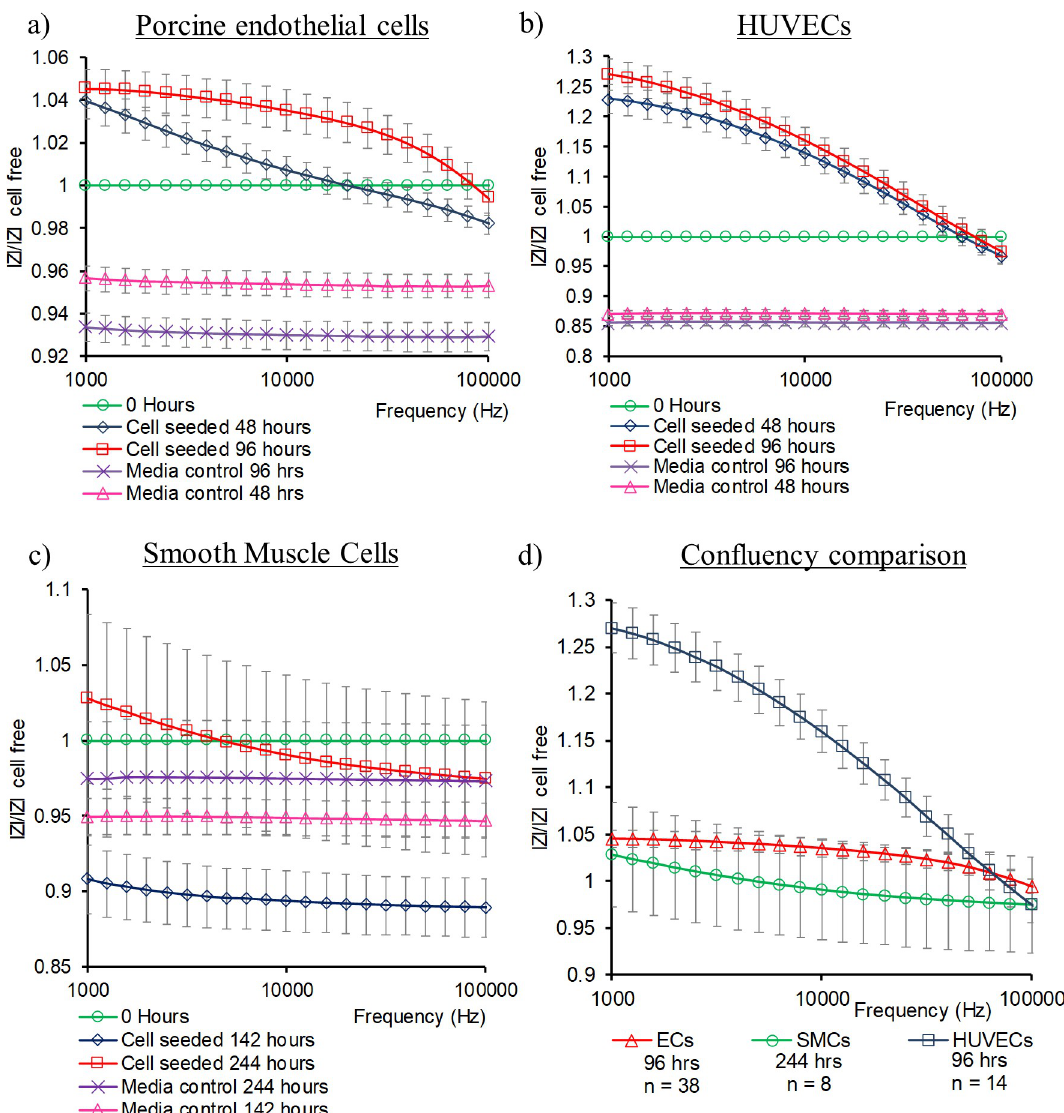
Fig 4. Mean total impedance ratio for confluent monolayers. (A) porcine ECs (n = 38) and media control electrodes (n = 33), (B) HUVECs (n = 14) and media control electrodes (n = 10), (C) SMCs (n = 8), and media control electrodes (n = 8), (D) Cell comparison at confluence. Error bars are ±